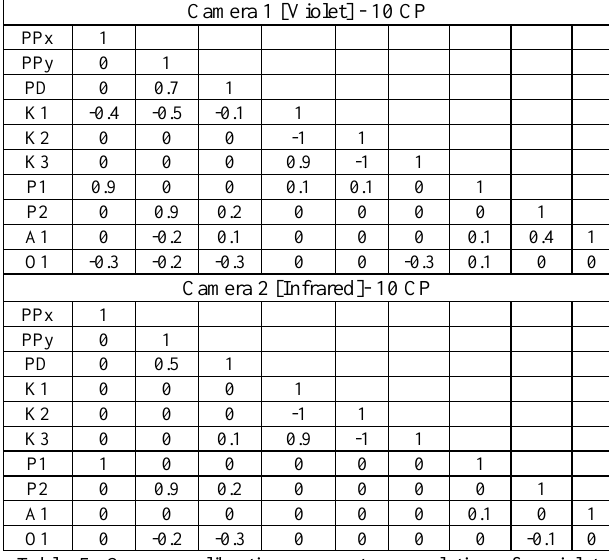
Table 5. Camera calibration parameter correlations for violet and infrared camera networks with 10 calibration parameters per camera. Correlations are in lower triangular matrix form. Observations of high parameter correlations in work by Tang and Fritsch (2013) confirmed the basis that